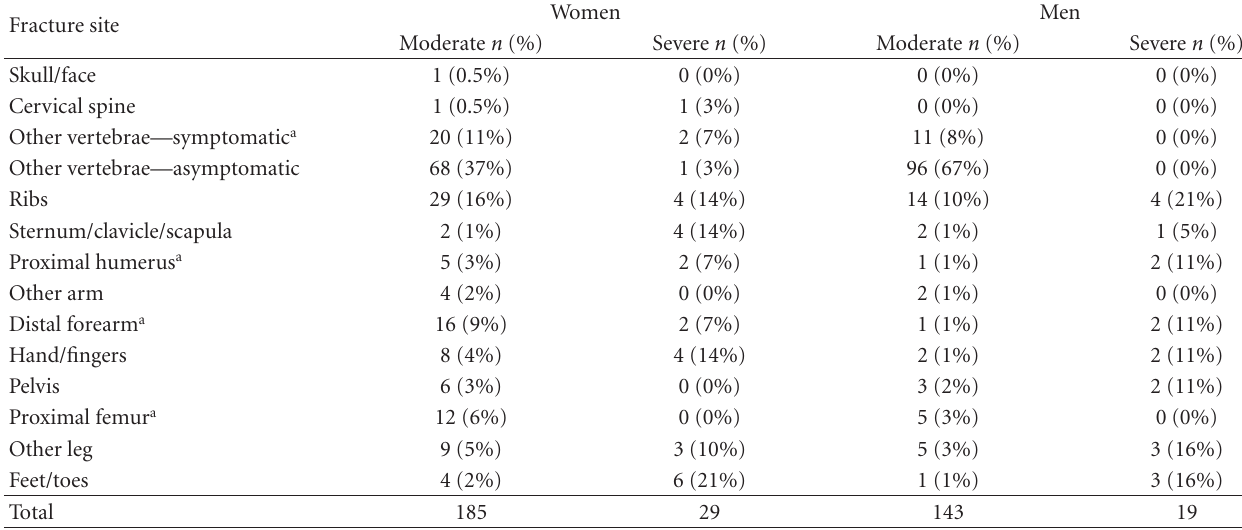
Table 2: Fracture outcomes over 10 years among Rochester, MN women and men ≥ 40 years of age at baseline, by precipitating trauma. Fracture site